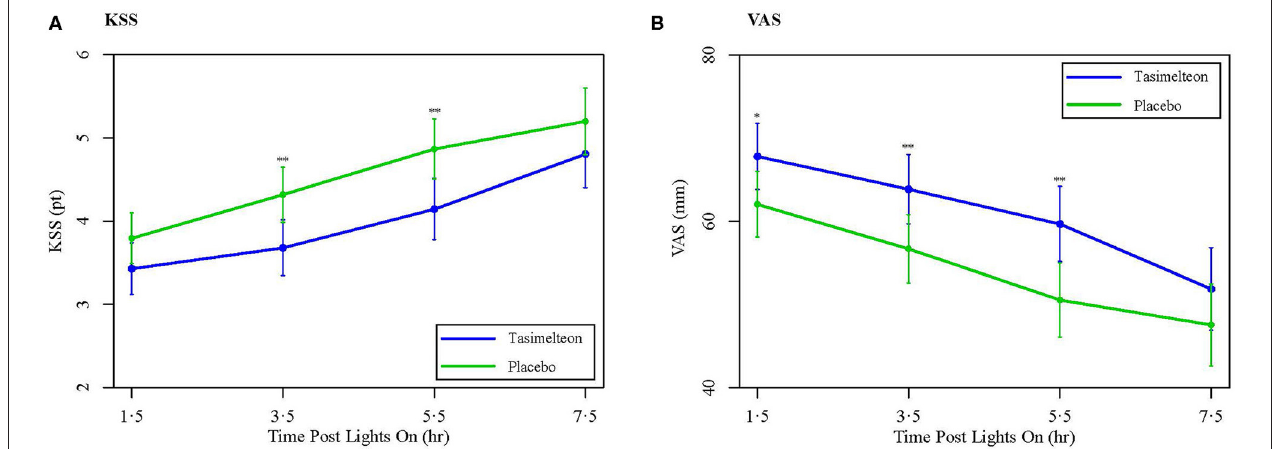
FIGURE 5 | (A) Data are LS Mean (95% CI) for average Night 1 KSS values between tasimelteon and placebo. KSS values, 1pt being extremely awake and 9 pts being extremely sleepy/fighting to stay awake, demonstrated a statistically significant decrease following the 8-h phase advance in the tasimelteon group compared to the placebo group for 3.5 and 5.5h post-lights on. ** P < 0.01. (B) Data are LS Mean (95% CI) for average Night 1 VAS values between tasimelteon and placebo. VAS values, 0mm being very sleepy and 100mm being very alert, demonstrated a statistically significant increase following the 8-h phase advance in the tasimelteon group compared to the placebo group for 1.5, 3.5, and 5.5h post-lights on. ** P < 0.01, * P <